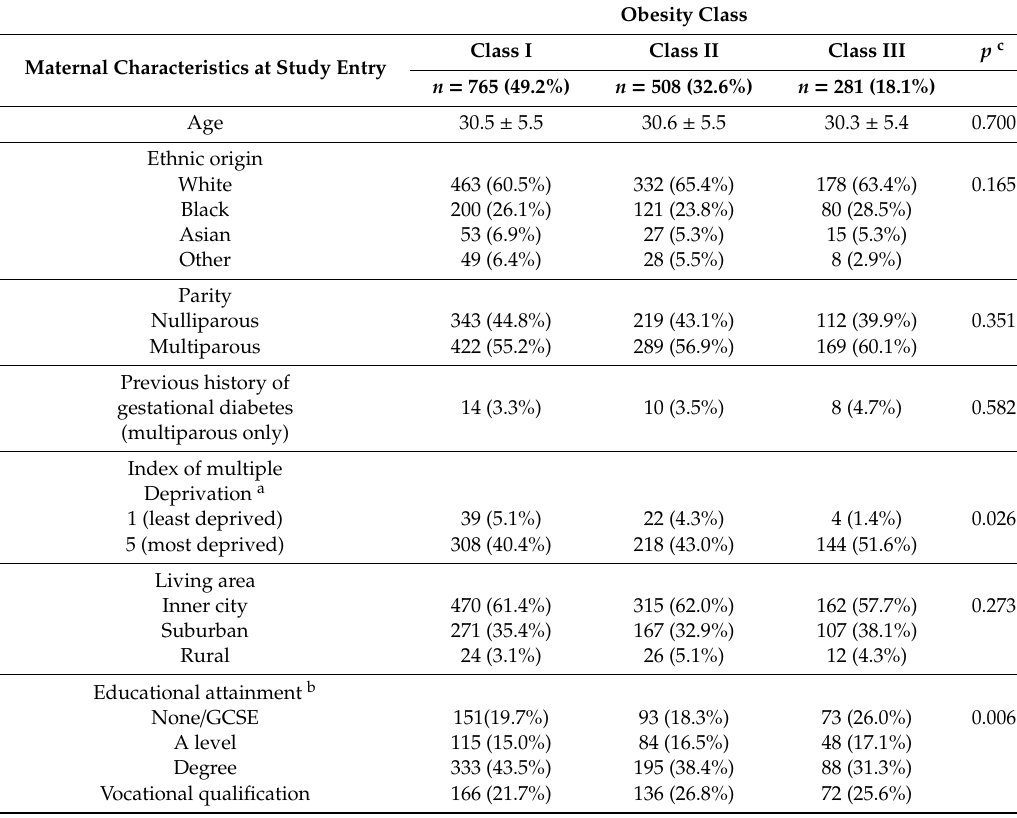
Table 1. Study entry characteristics of women by obesity